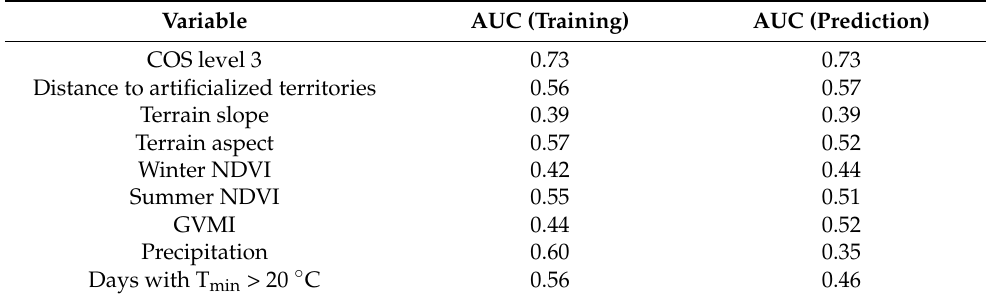
Table 9. Results of the validation of susceptibility models generated with training area 3, 6 years of occurrences and different individual environmental variables.